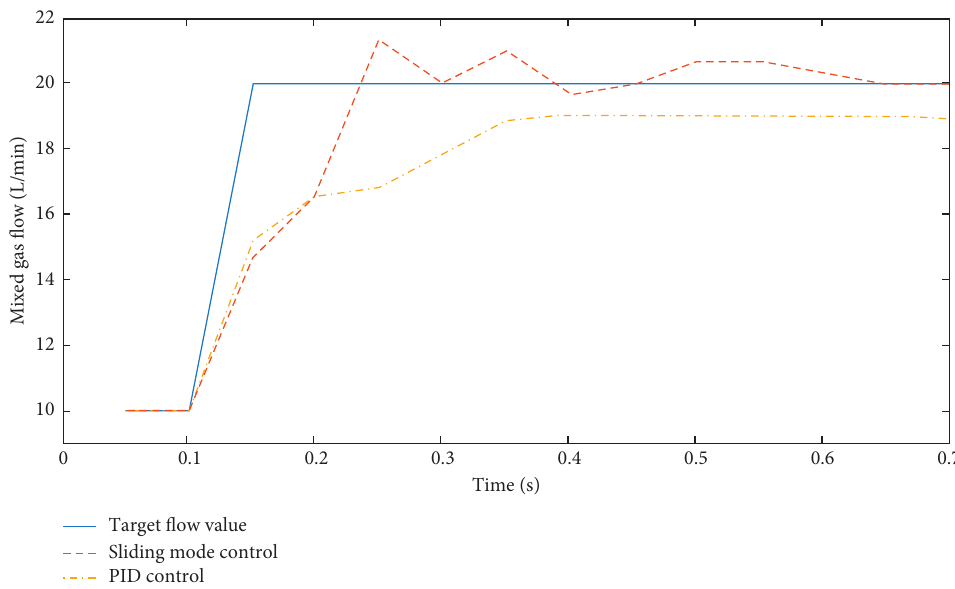
Figure 5: Comparison of actual flow output under the total flow regulation range of